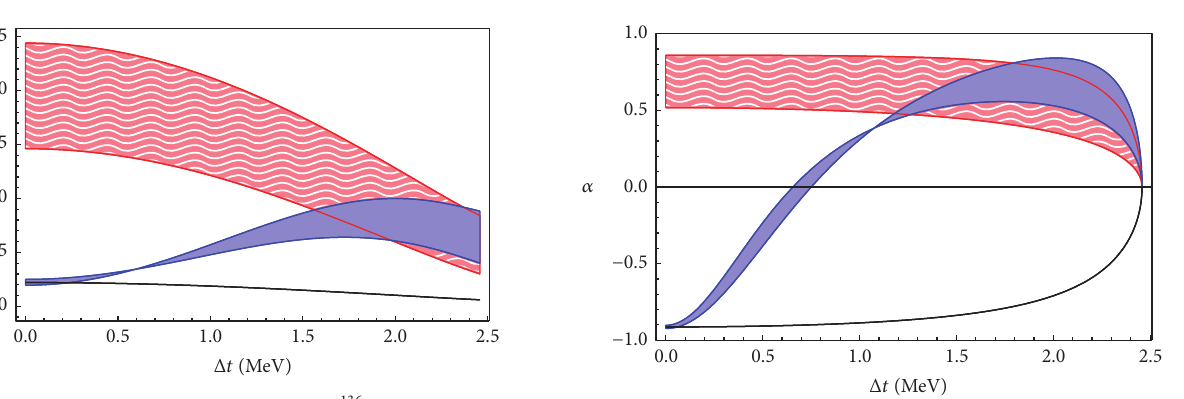
Figure 7: Same as Figure 5 for 136 Xe.